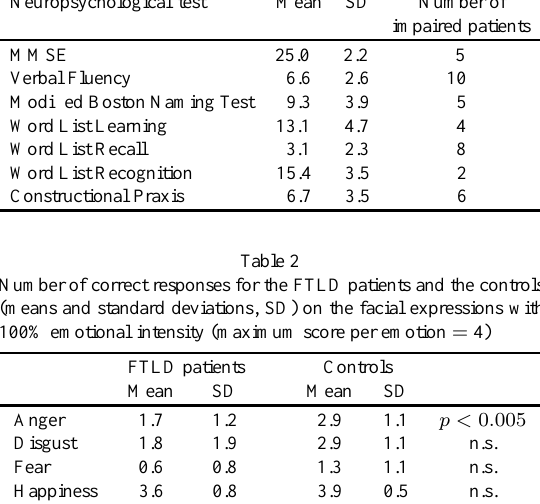
Table 1 Test results for the FTLD group on the CERAD battery [19] Neuropsychological test